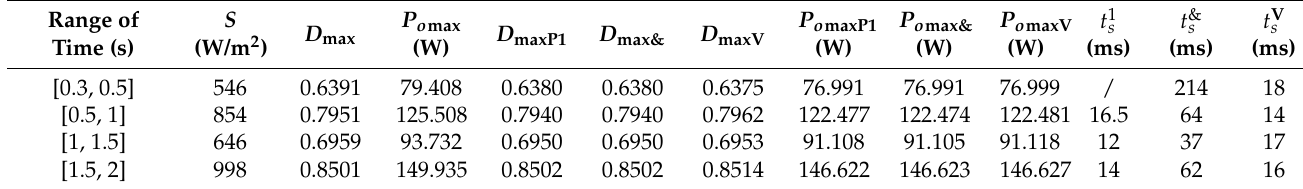
Table 10. Simulation parameters and results corresponding to Figures